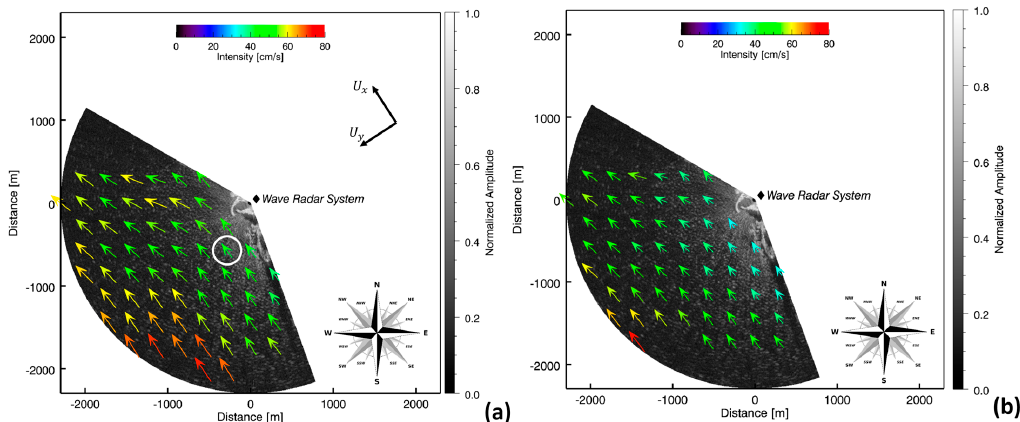
Figure 4. Radar image with over plotted the surface current field estimated during the measurement campaign on 15 May 2015. ( a ) Surface current field at 13:00 UTC; ( b ) Surface current field at 14:00 UTC.